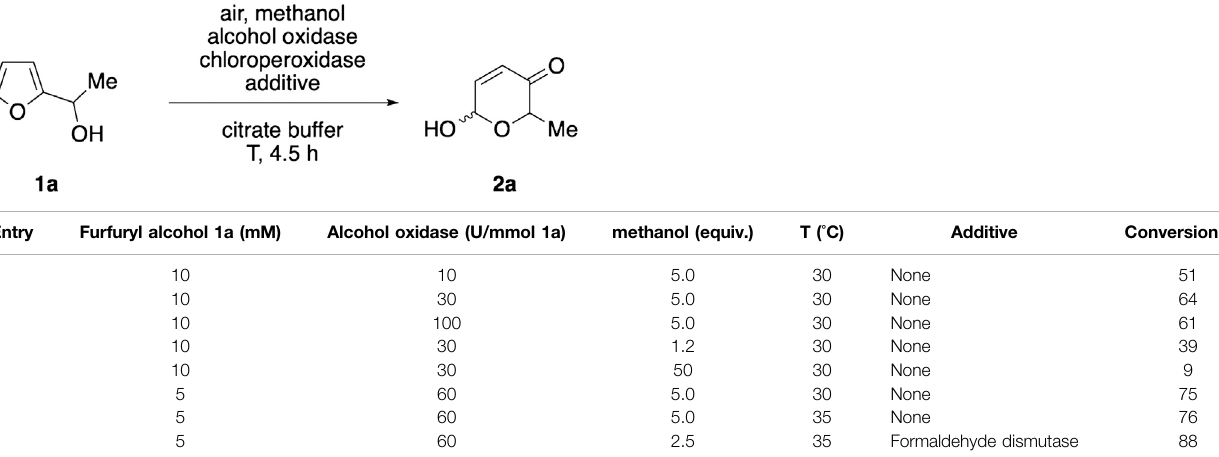
Entry Furfuryl alcohol 1a (mM) Alcohol oxidase (U/mmol